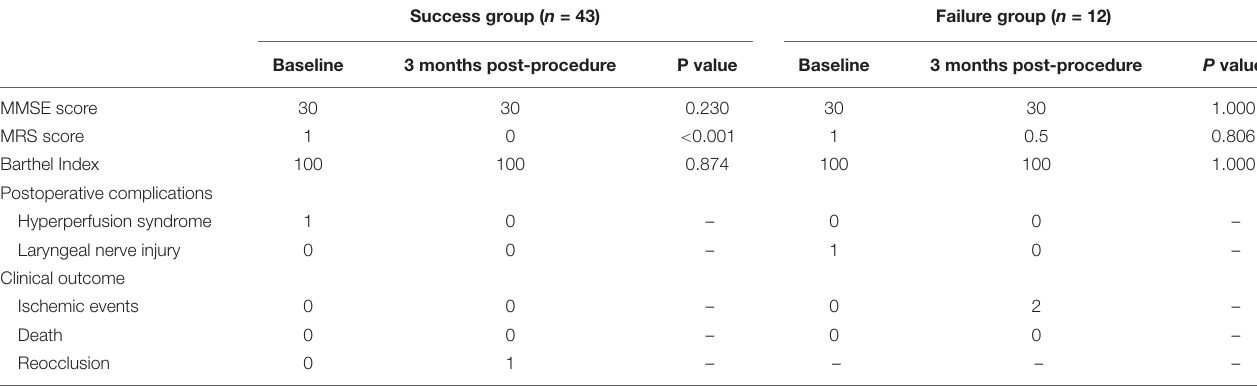
TABLE 3 | Outcomes and postoperative complications.